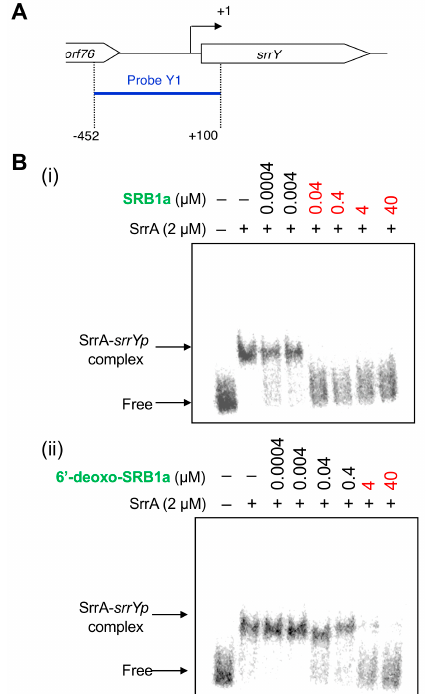
Figure 4. Gel shift assay of SrrA-binding in the upstream region of srrY . ( A ) Location of probe Y1 containing the srrY -promoter region ( srrYp ). The description of probe preparation was described previously [22]. ( B ) Effect of the SRB1 ( i ) and 6 ′ -deoxo-SRB1 ( ii ) on the binding of SrrA. Each reaction mixture contained 0.35 nM probe Y1 and 2 μ M recombinant SrrA protein. To the reaction mixture, various concentrations of either synthetic SRB1 ((1’ R )-isomer; Figure 1B) [11] or synthetic 6 ′ -deoxo-SRB1 ((1’ R )-isomer; Figure 1B) was added.